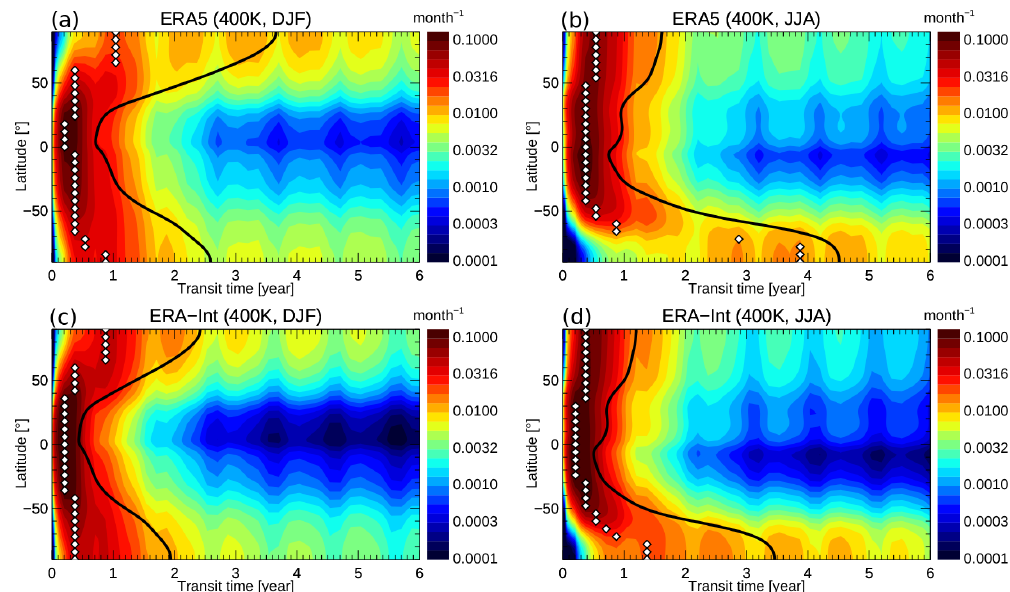
Figure 4. Age spectra at 400K (1989–2018 climatology) from ERA5 for boreal winter (a) and summer (b) . Panels (c) and (d) are the same but for age spectra from ERA-Interim. The black contour shows mean age (calculated as the first moment of spectra), and the white diamonds show modal age (peak of the